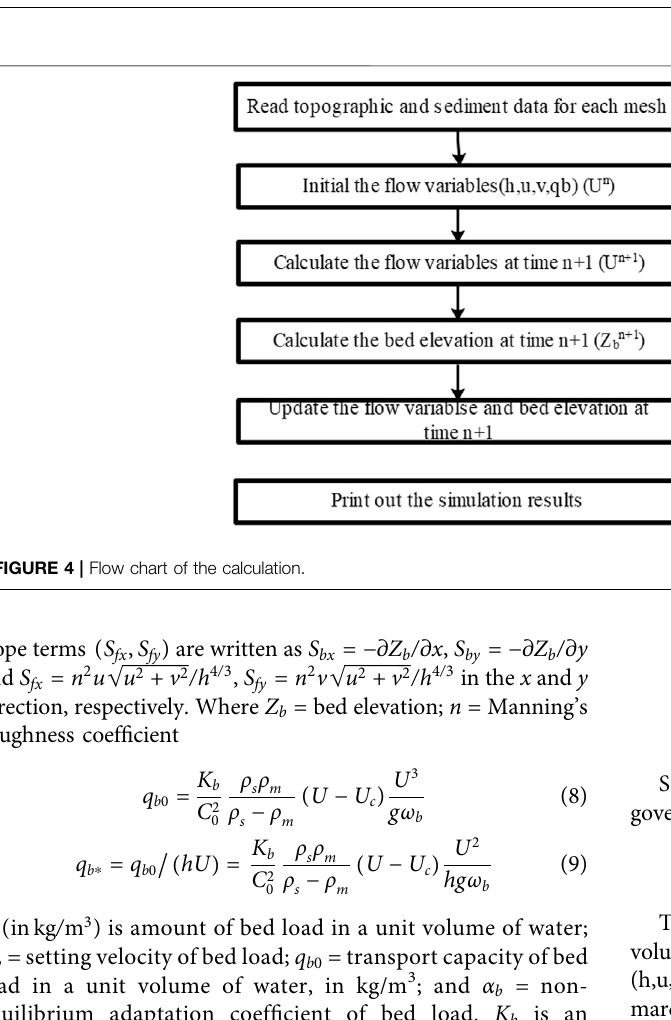
FIGURE 3 | Part of the calculation meshes.